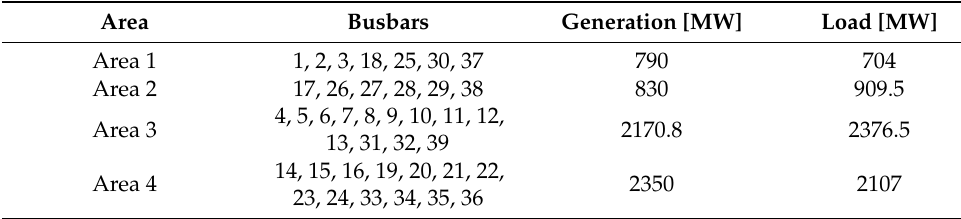
Figure 9. IEEE 39-Bus System . Table 1 shows the data in normal operation and the pre-contingency for each opera- tive area.